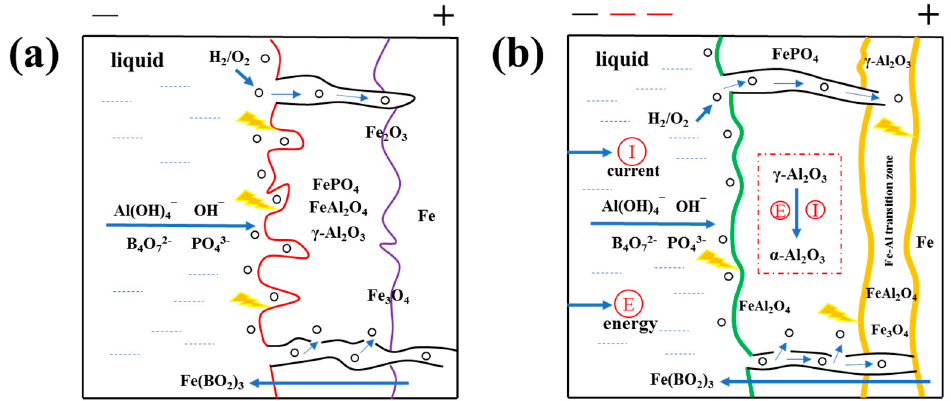
Figure 5. Schematic diagram of the MAO coating formation process before and after applying a negative voltage: ( a ) before and ( b ) after.